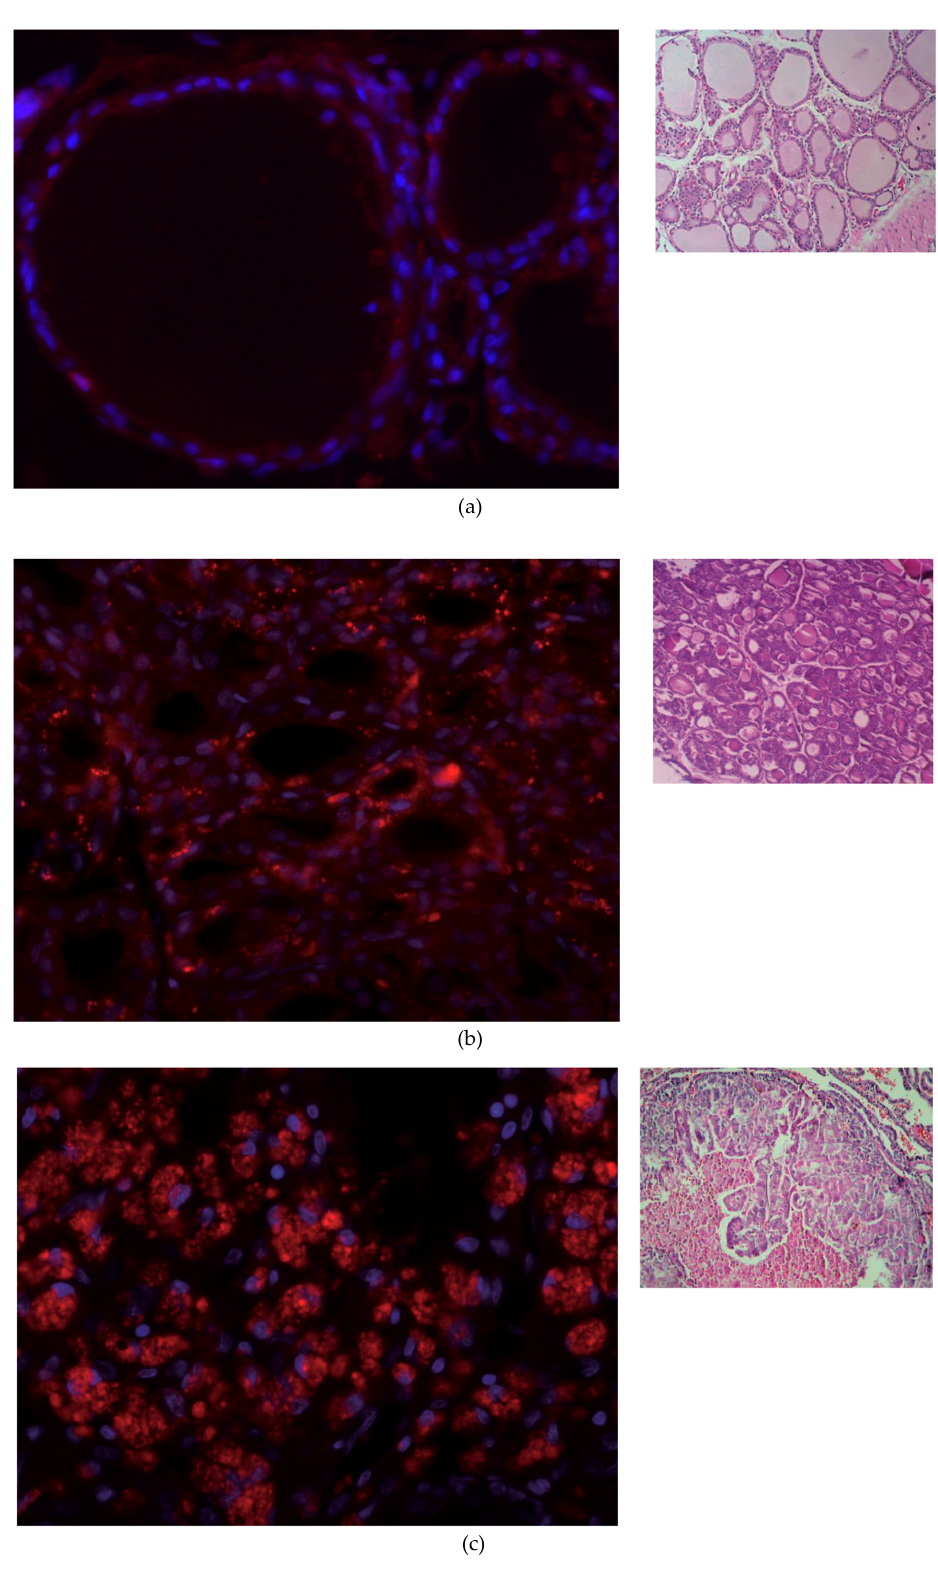
Figure 1. Immunofluorescence (left) and hematoxylin and eosin (H&E) staining (right) of thyroid tissue. Red: NIS primary antibody, and blue: nuclear counterstaining with DAPI. ( a ) Normal thyroid. ( b ) Thyroid with hyperplasia. ( c ) Papillary thyroid cancer. A papilla formation is observed. Immunofluorescence image magnification is 400. H&E staining magnification in ( a ) is 100 and in ( b ) and ( c ) is 200.